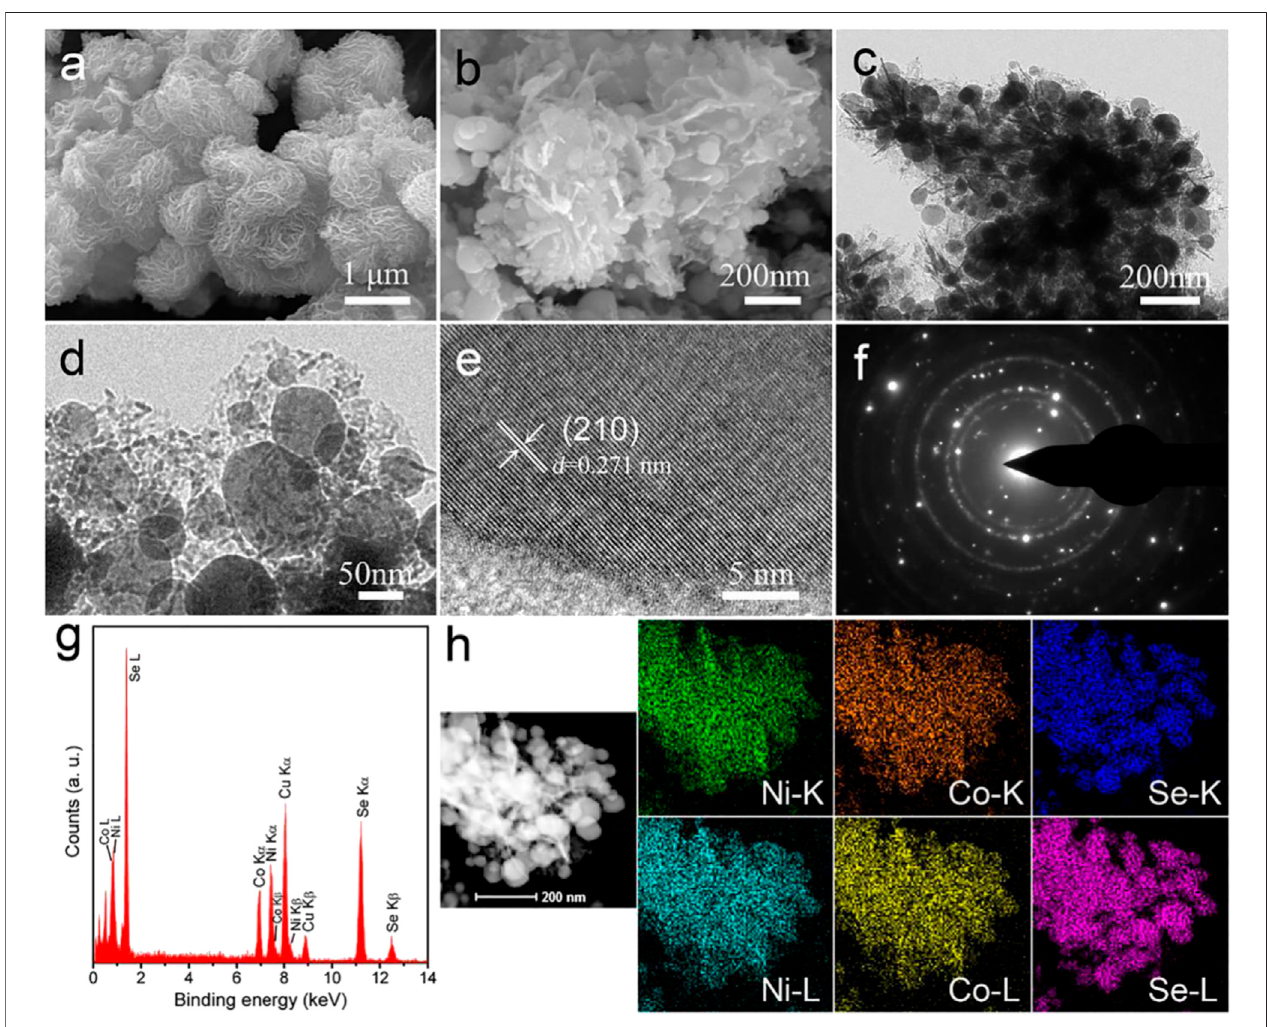
FIGURE 14 | Organometallic framework compound ZIF-7 as the